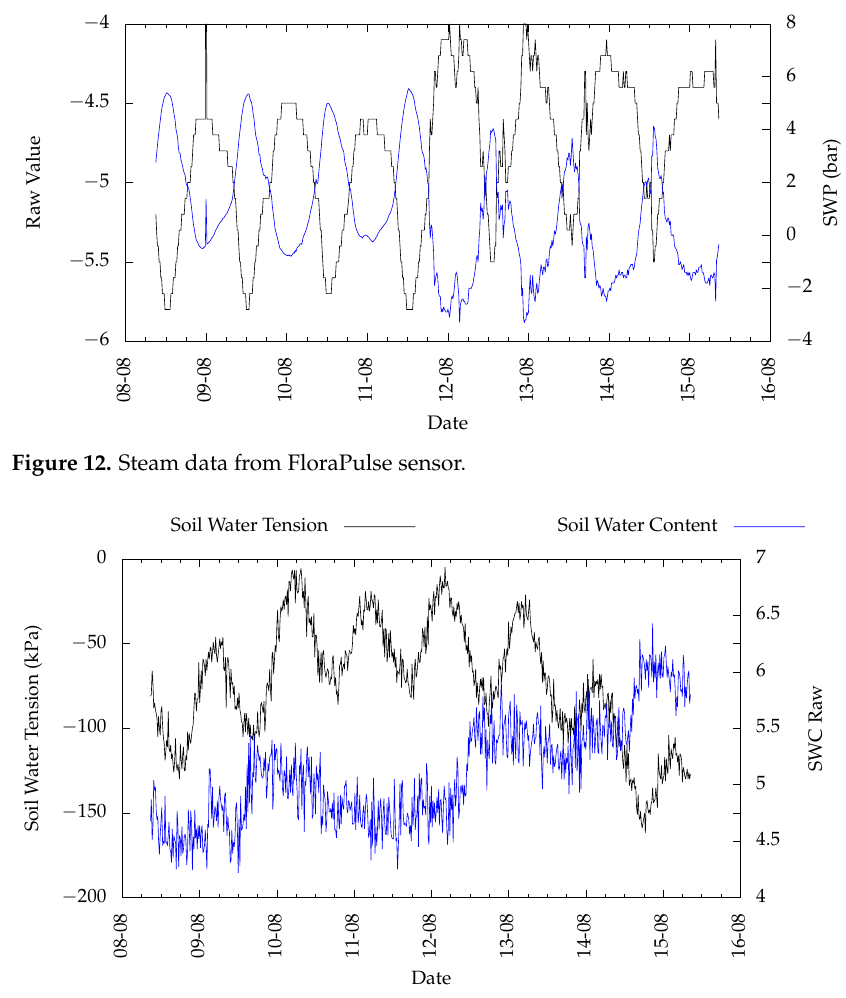
Figure 13. Soil moisture from TEROS21, water tension, and TEROS12, volumetric water content.